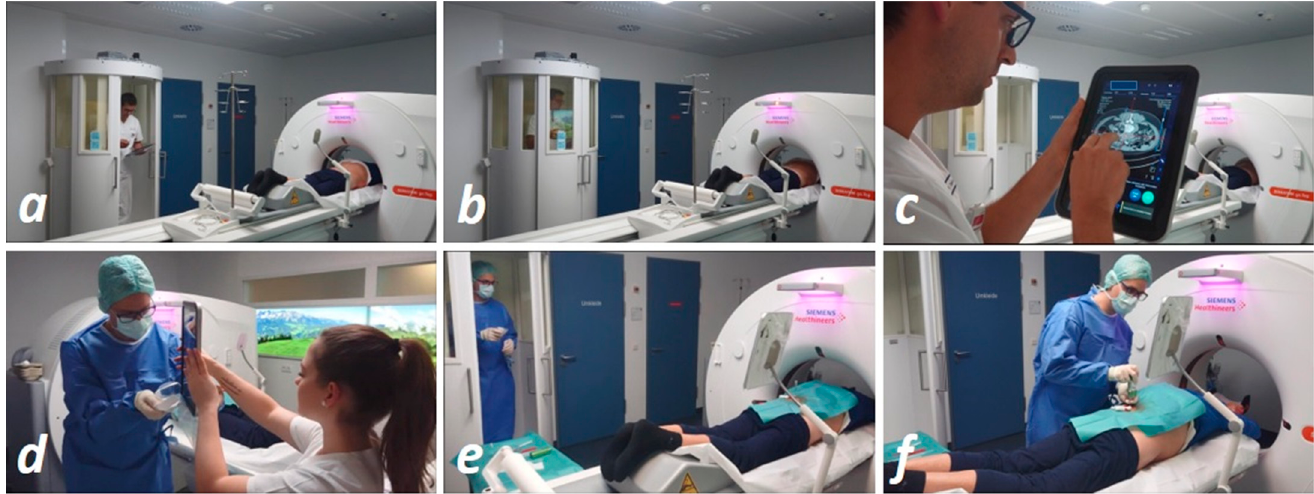
Figure 1. Procedure of the novel mobile workflow: ( a ) tablet PC and remote control are used to set up for initial scanning; ( b ) doors of the radiation protection cabin are closed via the foot switch during scanning; ( c ) planning of the needle path is performed on the touchscreen of the tablet; ( d ) for the aseptic part of the intervention, the remote control and tablet PC are packed sterile; ( e ) during the stepwise needle placement, scanning is performed from the radiation protection cabin by the radiologist; ( f ) biopsy of the lesion.